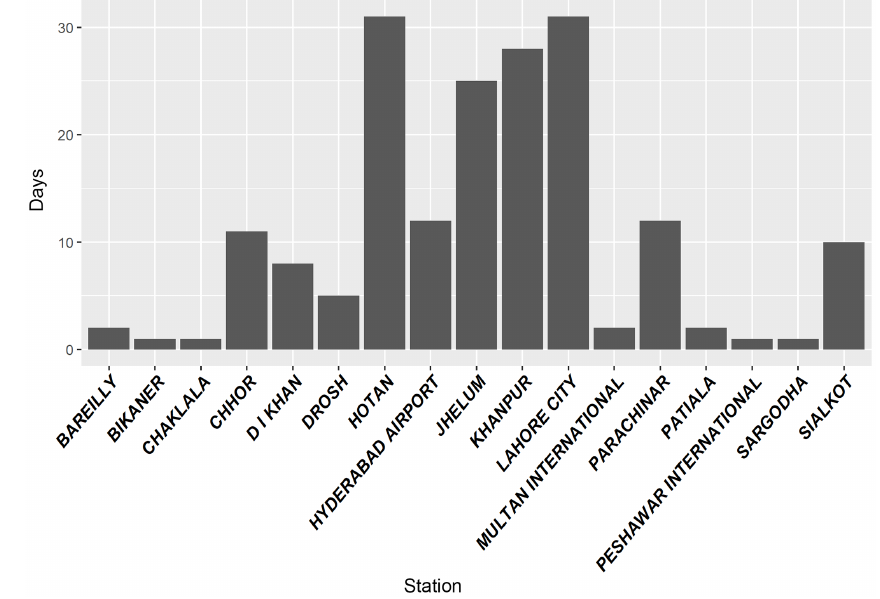
Figure A2. Data missing rate in the National Climatic Data Center in the study areas.